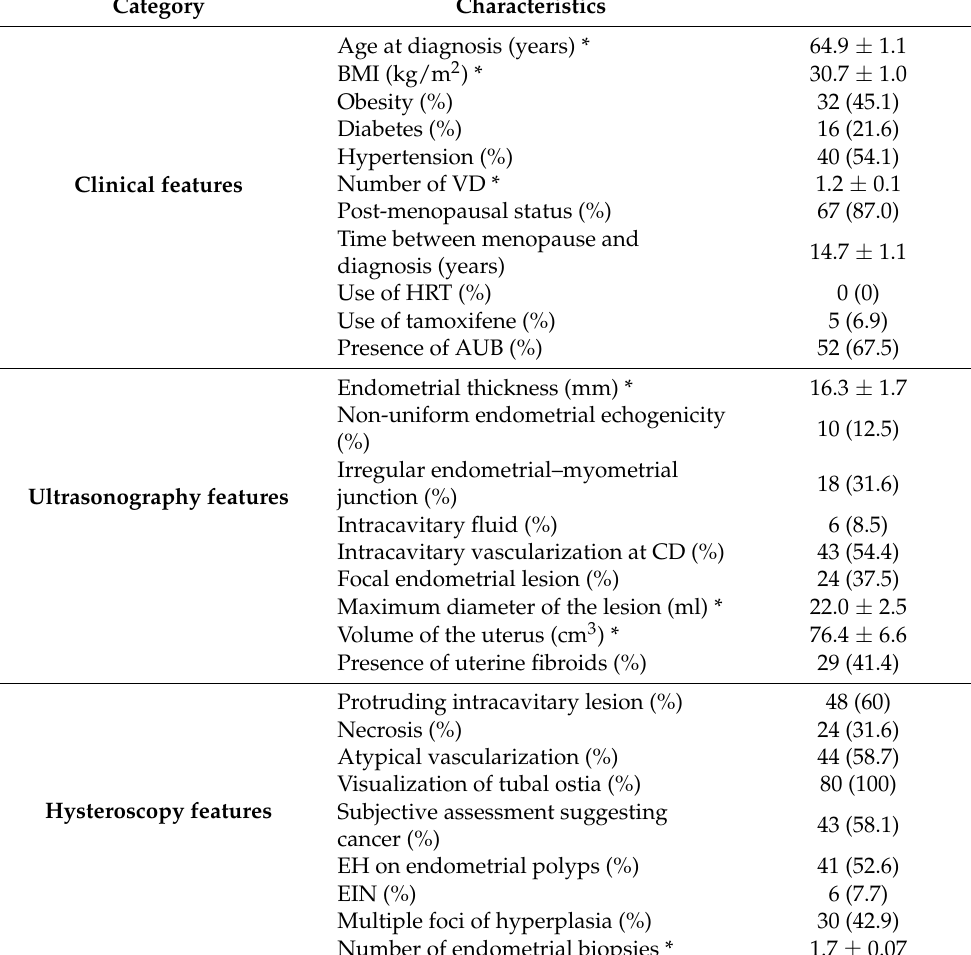
Table 1. Characteristics of the study